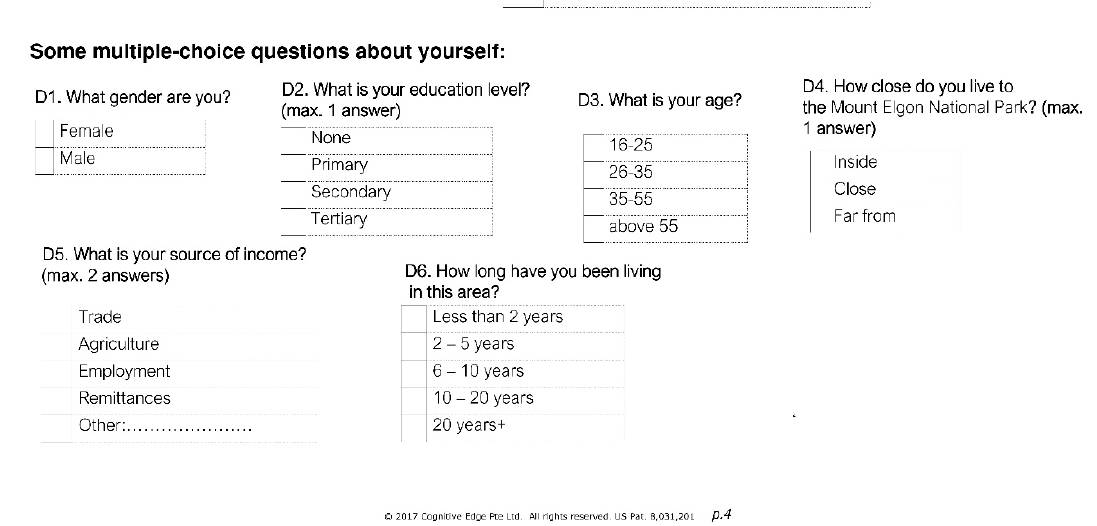
Figure A4. Information about Respondent Section, using multiple choice